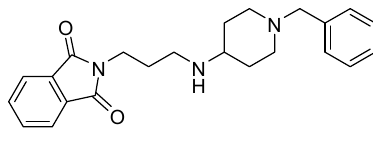
Figure 5. The starting point of our research—compounds 1 and 2 . They are both acetyl- and butyryl-cholinesterase inhibitors with micromolar IC